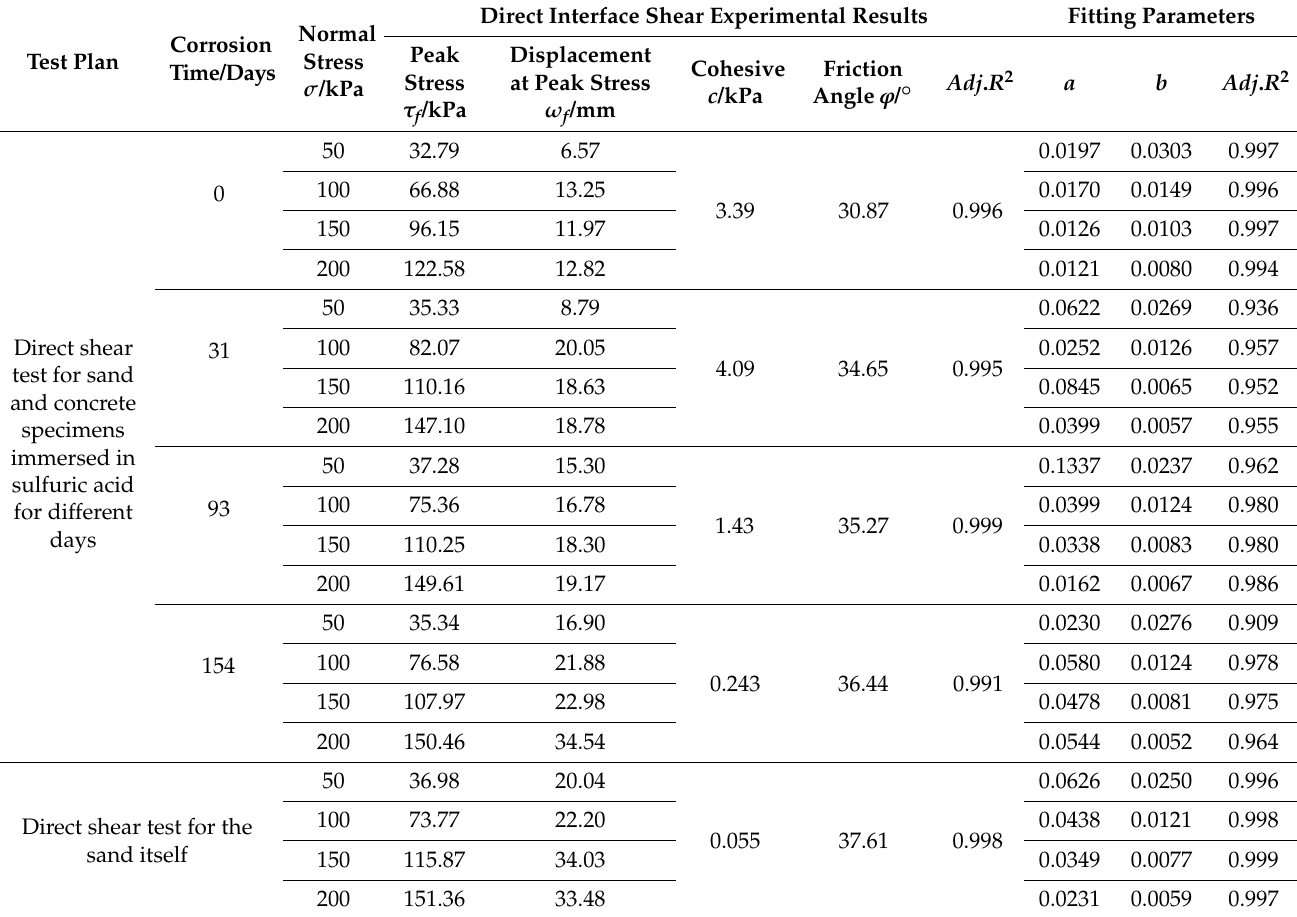
Table 4. Direct interface shear experimental results and fitted parameters of the experimental